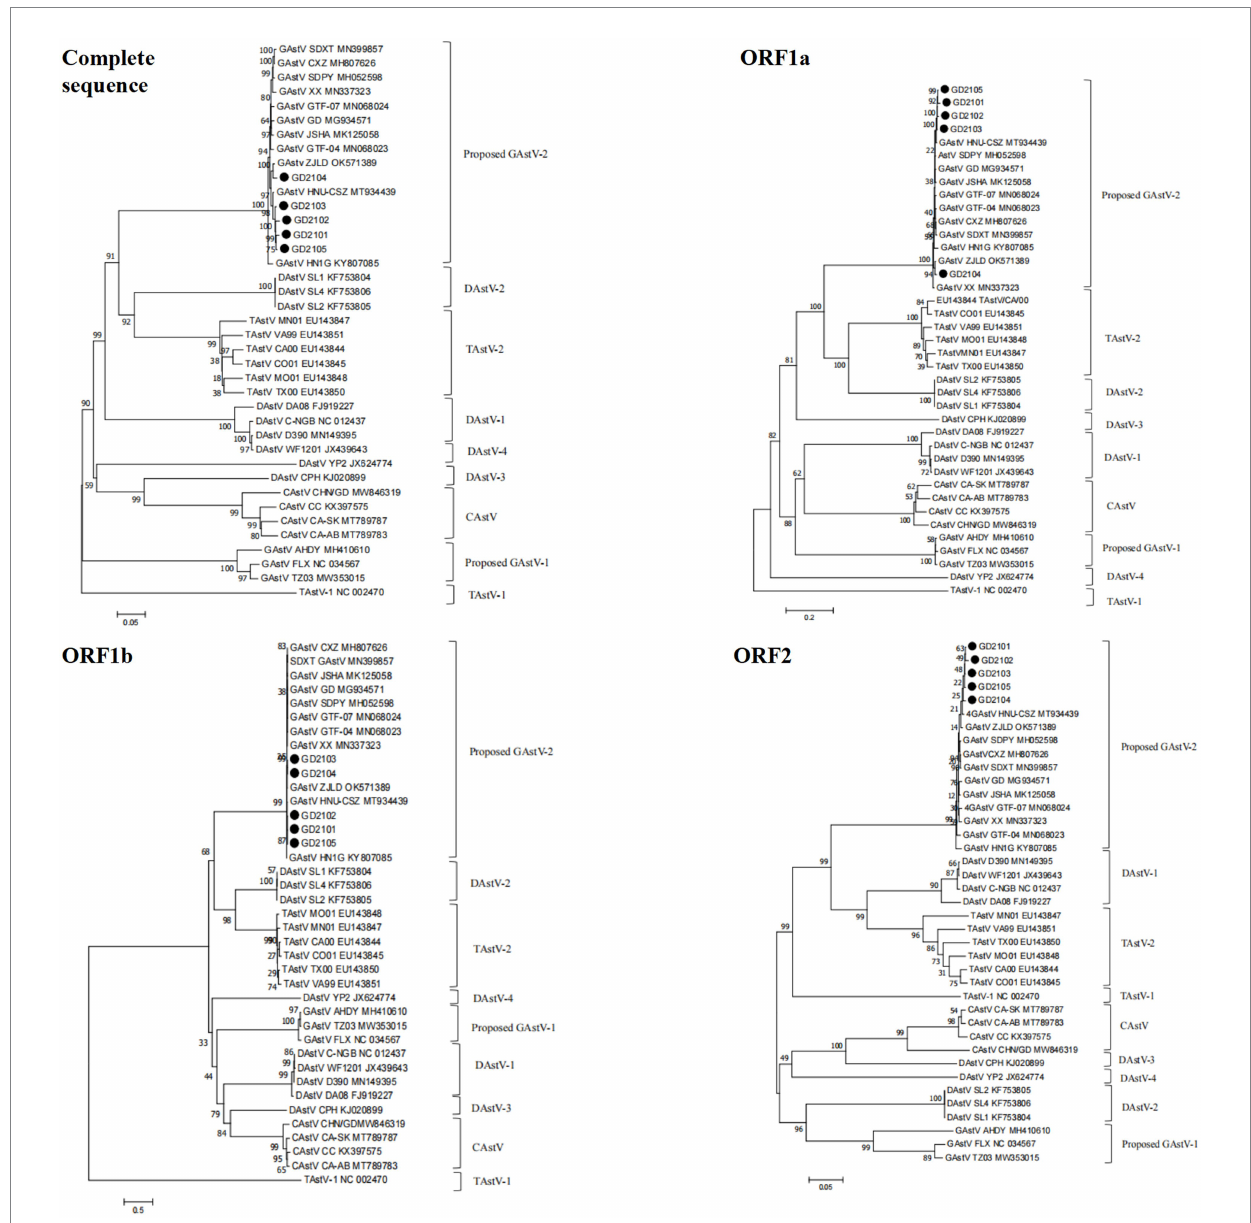
FIGURE 5 Genetic evolution analysis between five GoAstV isolates and other avian astroviruses. The evolutionary trees were generated using MEGA7.0 and the adjacency method was used with 1,000 bootstrap repeats. The black dots represent the strains isolated in this study.